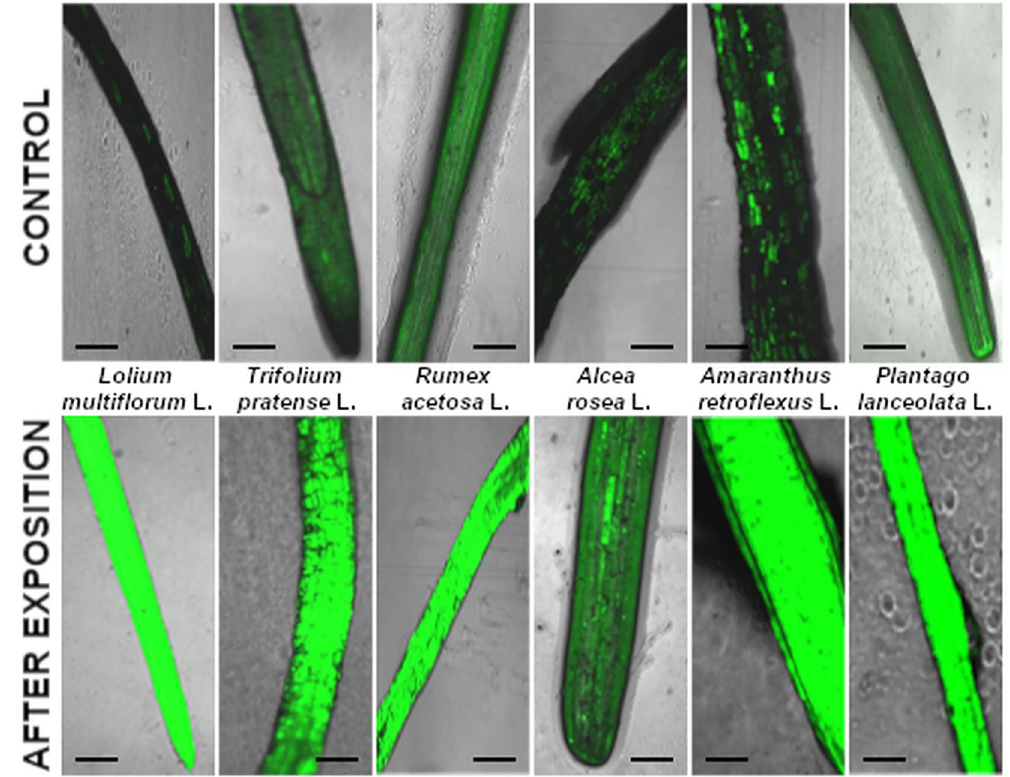
Figure 4. Fluorescent images show H 2 O 2 production in leaves of examined species after exposure, (abbreviations see “Materials and methods”). The bar indicates 1